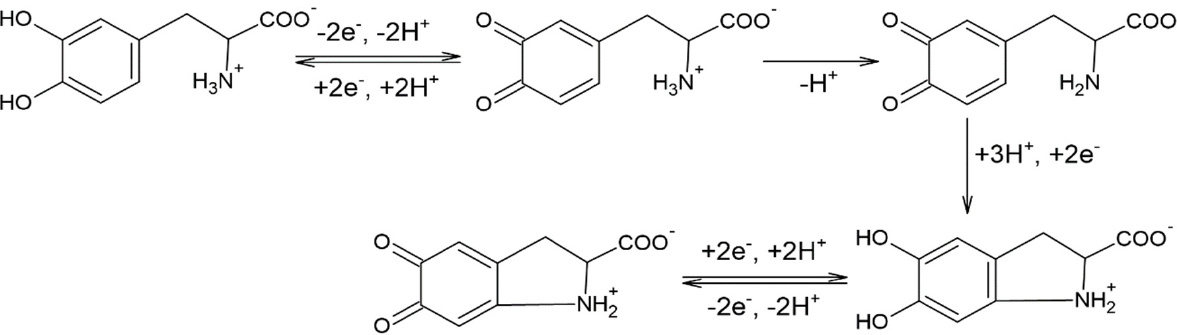
Figure 6. Mechanism of L-DOPA oxidation.